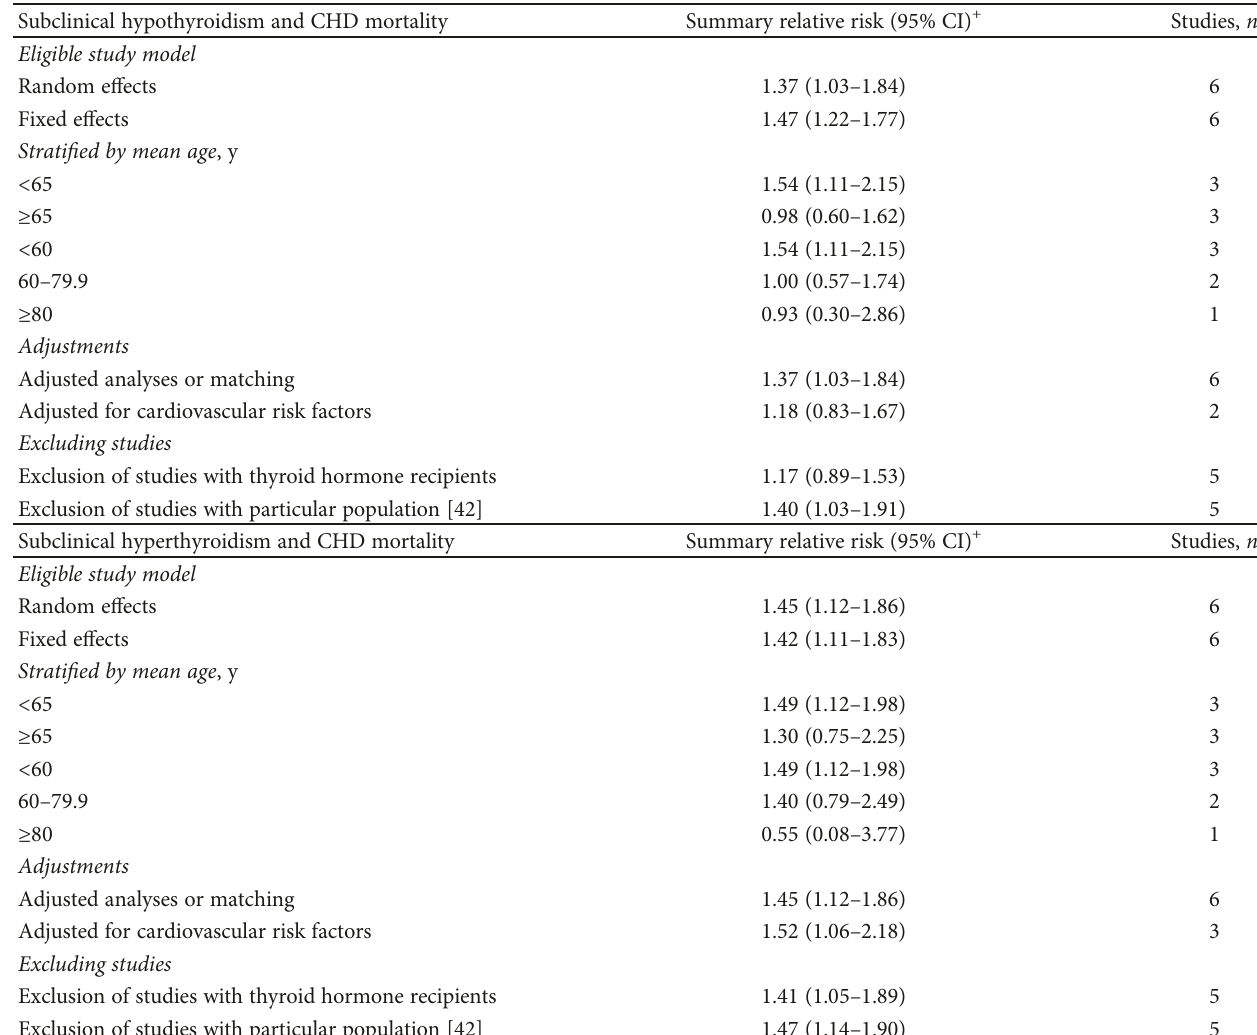
Table 4: Strati fi ed and sensitivity analysis of the subclinical thyroid